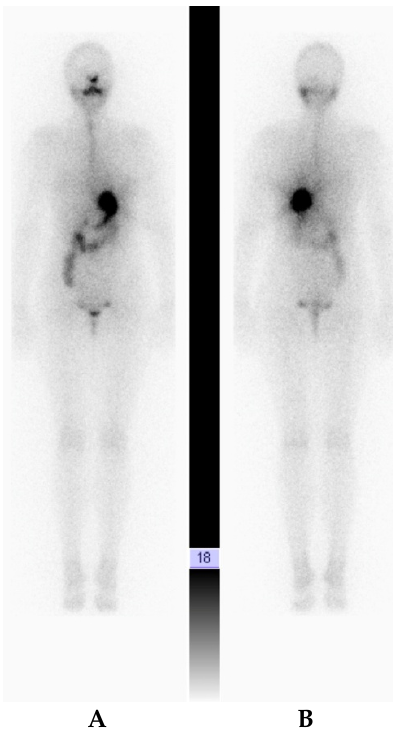
Figure 3. Whole Body Scan with I-131 sodium iodide (I-131 WBS) with 185MBq at 24 h post- administration, showing no thyroid remnant uptake and no abnormal uptake in other sites (( A ) anterior, ( B )